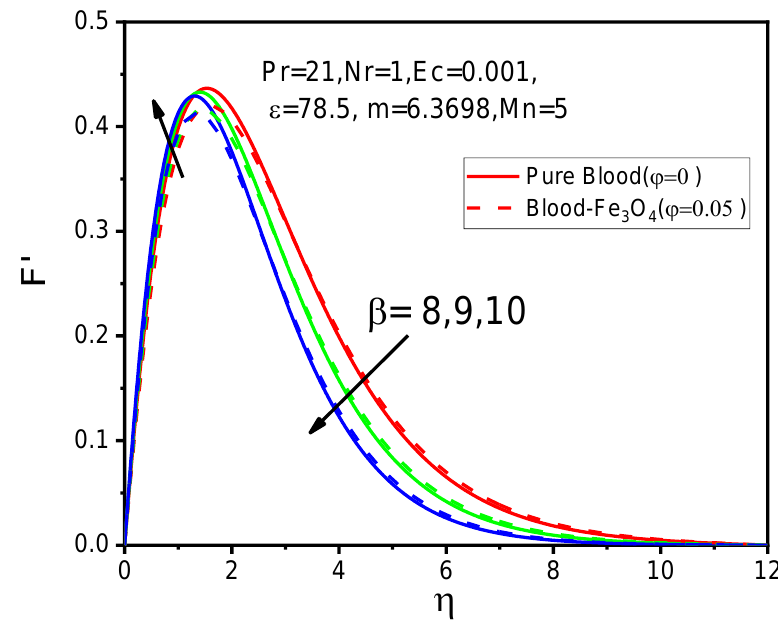
Figure 4. (Case a): Variations of F (cid:48) for β = 8 , 9, 10 against η .